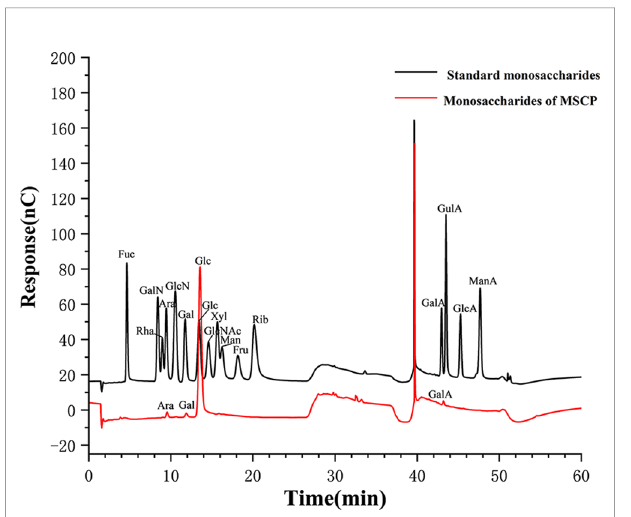
FIGURE 3 | Fourier-transform infrared (FT-IR) spectra of MSCP in the range of 4000 – 400 cm -1 .